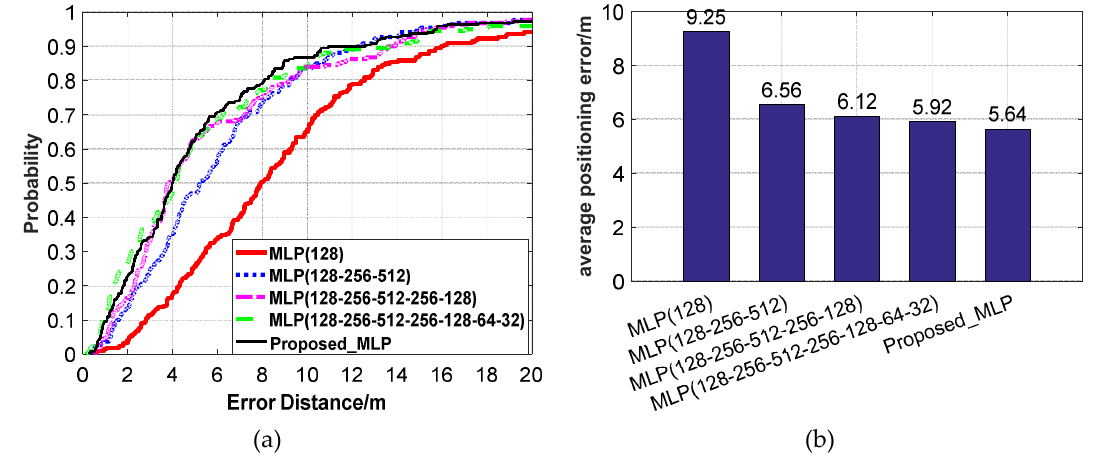
Figure 14. The positioning accuracy using different MLP network structures. ( a ) CDF positioning errors. ( b ) Average positioning errors.